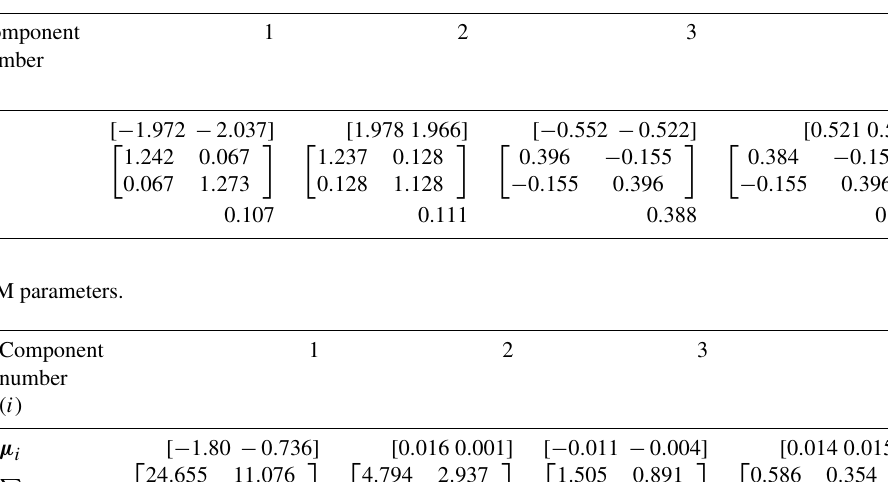
Table 1. Initial GMM parameters.